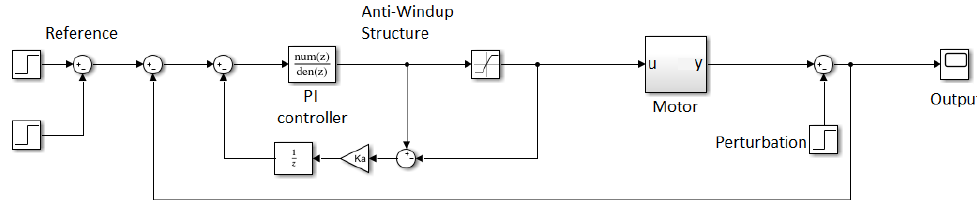
Figure 12. Block diagram of the DC motor angular speed